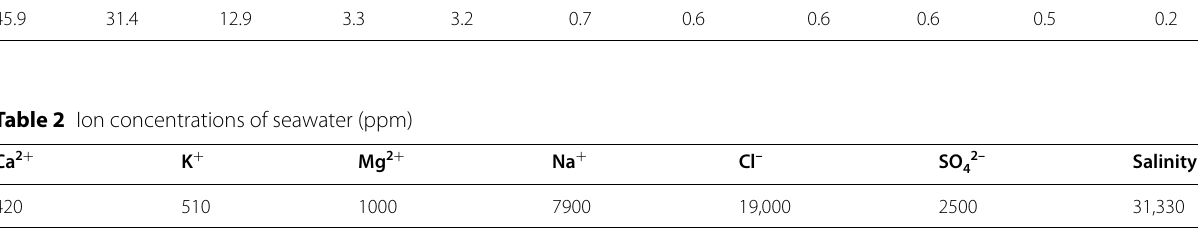
Table 1 Chemical compositions (oxides in wt.%) of BFS CaO SiO 2 Al 2 O 3 SO 3 MgO